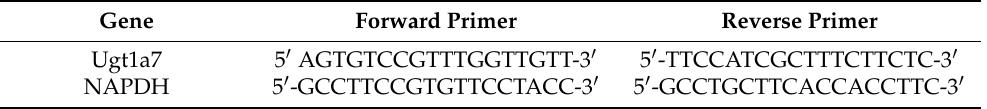
Table 6. Primers sequences for qRT-PCR